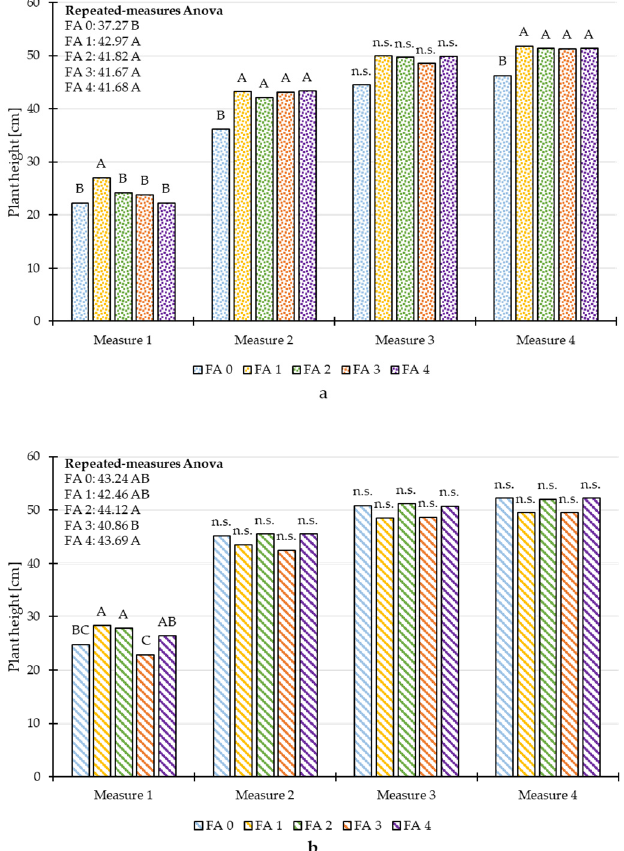
Figure 8. Plant heights in 2020 ( a ) and 2021 ( b ). FA0: only water; FA1: 8 g L − 1 of CaO; FA2: 12 g L − 1 of CaO; FA3: 8 g L − 1 of CaO + 16 g L − 1 of urea; FA4: 12 g L − 1 of CaO + 16 g L − 1 of urea. n.s. = not significant. Values with different letters are significantly different at p ≤ 0.05 according to Tukey’s test.